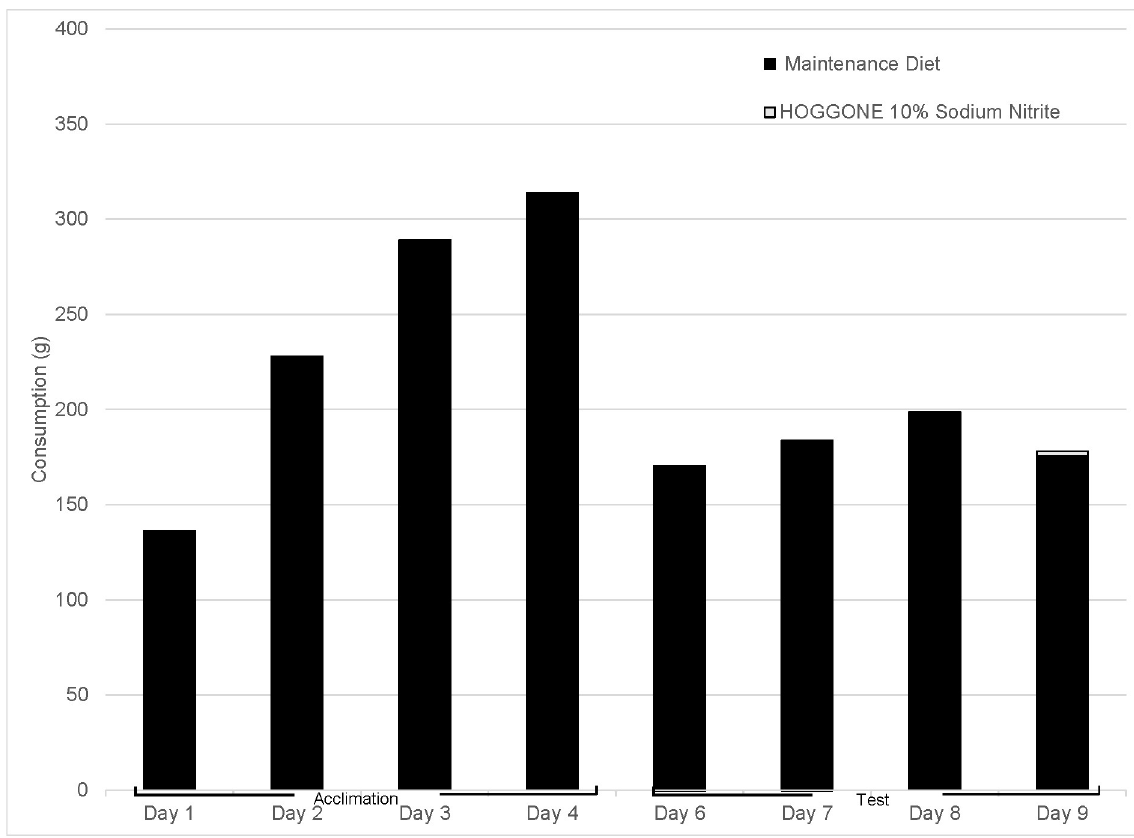
Fig 4. Consumption of the maintenance diet and treated HOGGONE bait (10% sodium nitrite) in Experiment 4. This experiment was designed to determine how experimentally-na ï ve European starlings interact with the novel HOGGONE bait matrix and identify associated mortality or morbidity.